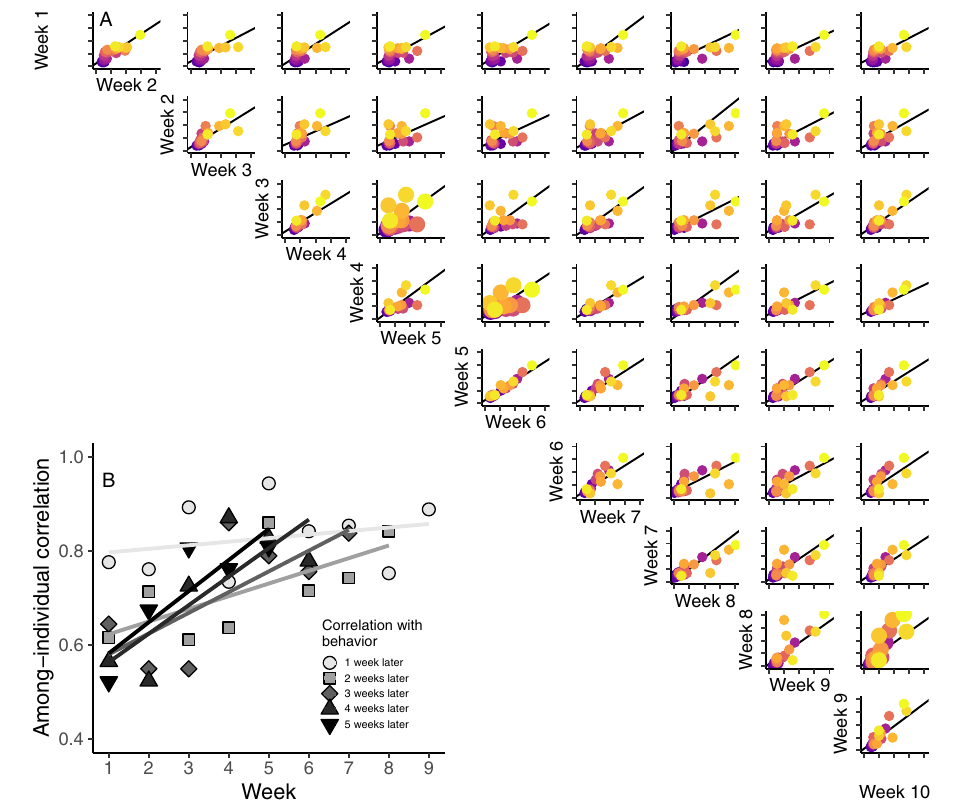
Fig.4|Earlier-in-lifeindividualitypredictlater-in-lifeindividuality.A Individual behavior was signi fi cantly positively correlated across all 10 weeks of observation. Each plot represents the among-individual correlation in behavior between two particular weeks in the ten-week experiment. The points in the plot represent the individual ’ s behavior for that week; throughout, individuals are colored according to their week 1 behavior where yellow represents greater swimming speeds and purple represents lower swimming speeds. The line on each plot is the estimated